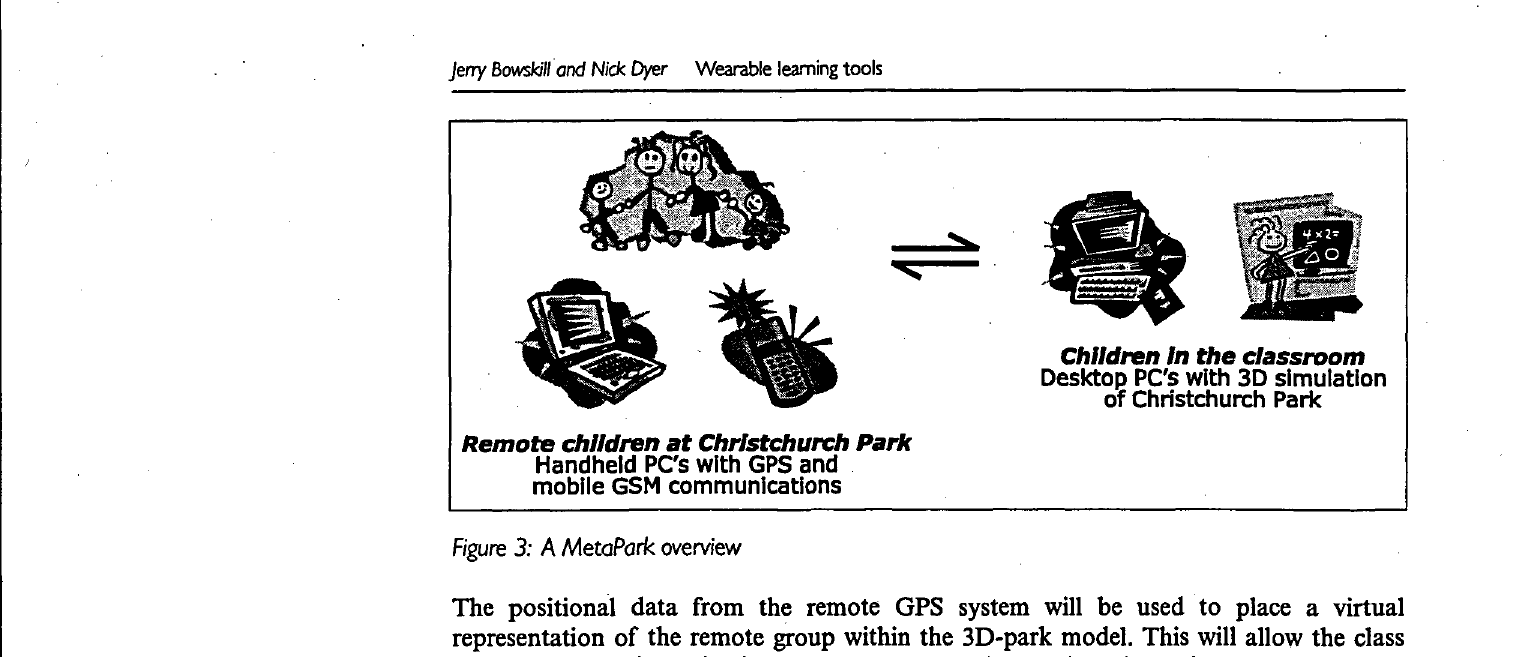
Figure 3: A MetaPark